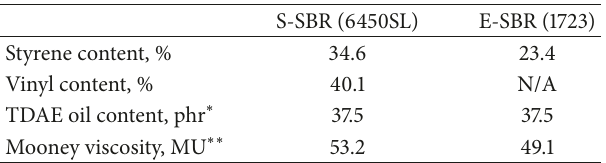
Table 1: Typical properties of E-SBR and S-SBR employed in this